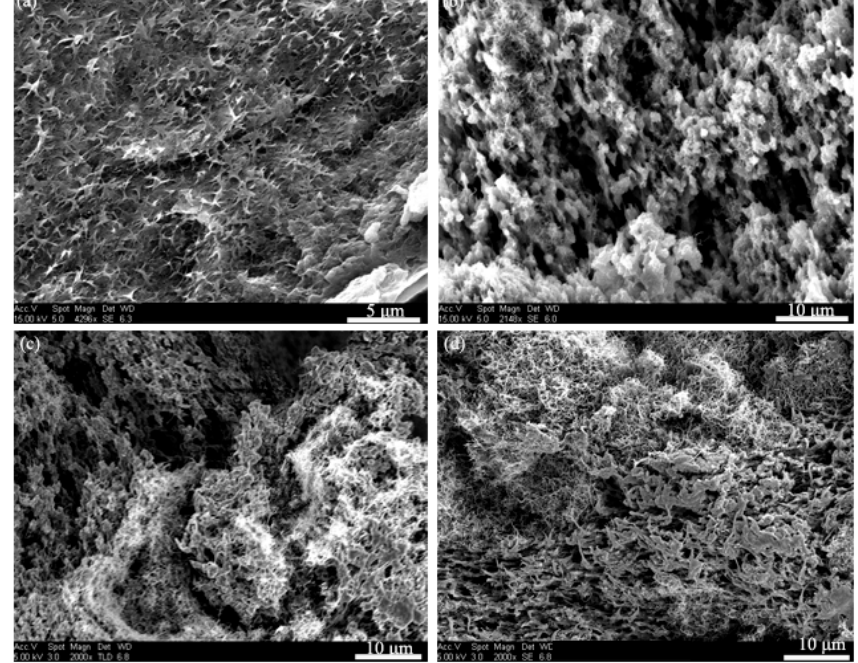
Figure 1. The cross-section microstructure of PVDF/MWNTs composites with ( a ) 7 wt.% MWNTs; ( b ) 15 wt.% MWNTs; ( c ) 25 wt.% MWNTs and ( d ) 35 wt.% MWNTs.